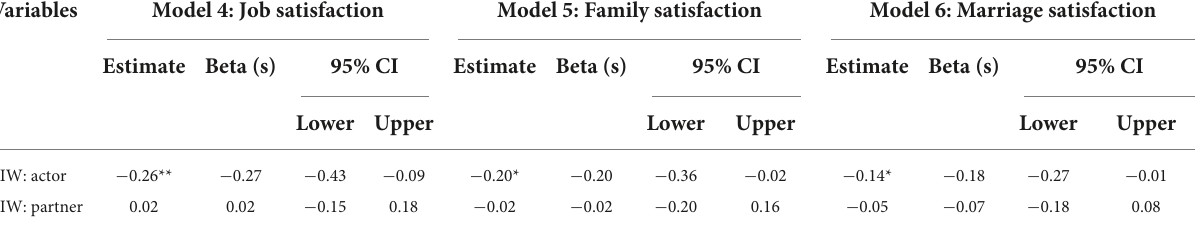
TABLE 3 The APIM results from FIW to dependent variables of stay-at-home spouses. Variables Model 4: Job satisfaction Model 5: Family satisfaction Model 6: Marriage